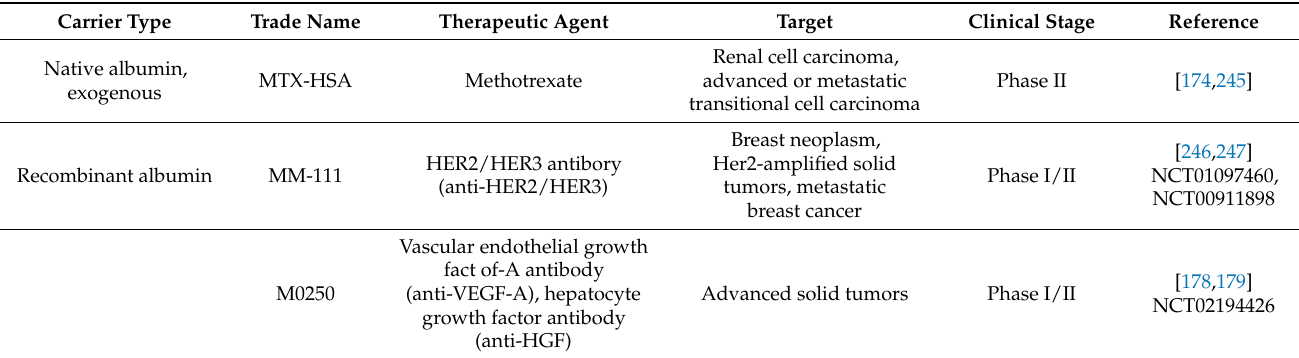
Table 1. Albumin-binding anticancer drugs in clinical